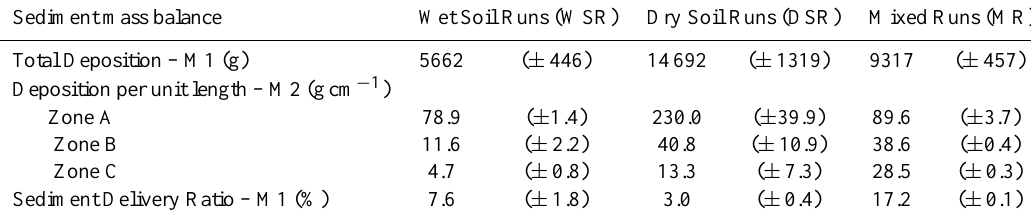
Table 1. Sediment mass balance of the depositional area for the three simulation experiments. Sediment mass balance